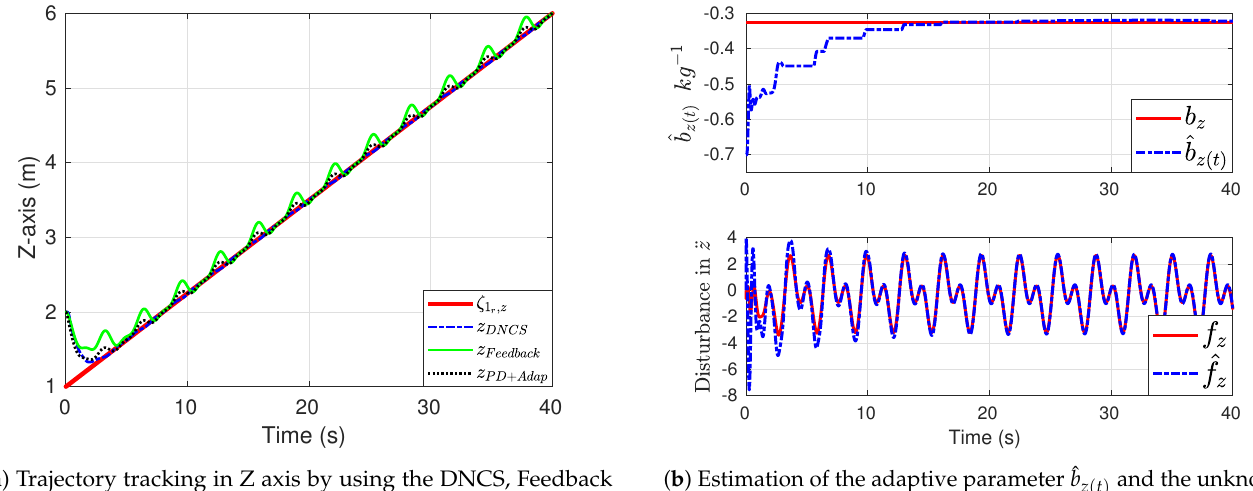
( b ) Estimation of the adaptive parameter ˆ b z ( t ) and the unknown function ˆ f z . Figure 8. Simulation results for trajectory tracking of a 3D helical reference signal in Z